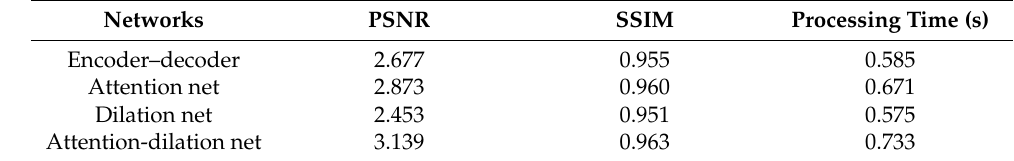
Figure 7. Local binarization and evaluation method. ( a ) the flowchart of the method; ( b ) detection boxes on the ground truth image; ( c ) GPR images reconstructed by the four networks; ( d ) binarize the chosen area. Table 1. Performance of each variants of